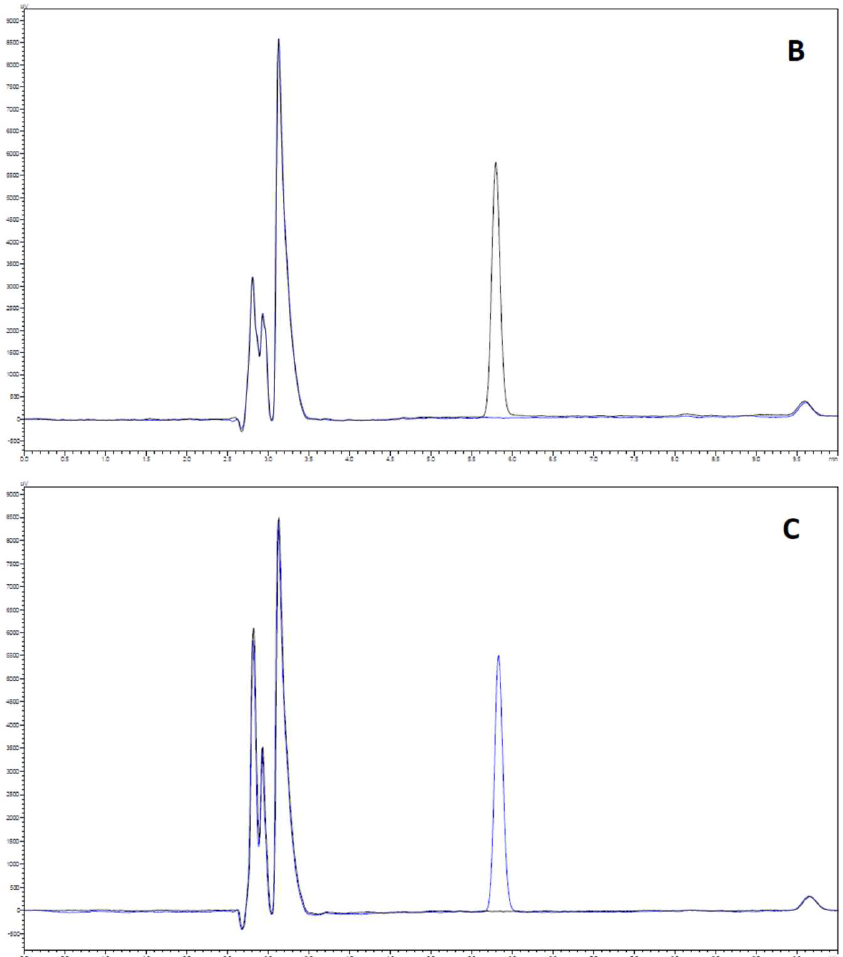
Figure 2. Representative HPLC chromatograms of the analysis of blank and spiked samples (with 10 µ g mL − 1 PAR). ( A ) FaSSGF: milk (4:1); ( B ) FaSSIF: milk (4:1); ( C ) FeSSIF: milk (4:1). Full-fat (3.6%) milk was used in all cases.